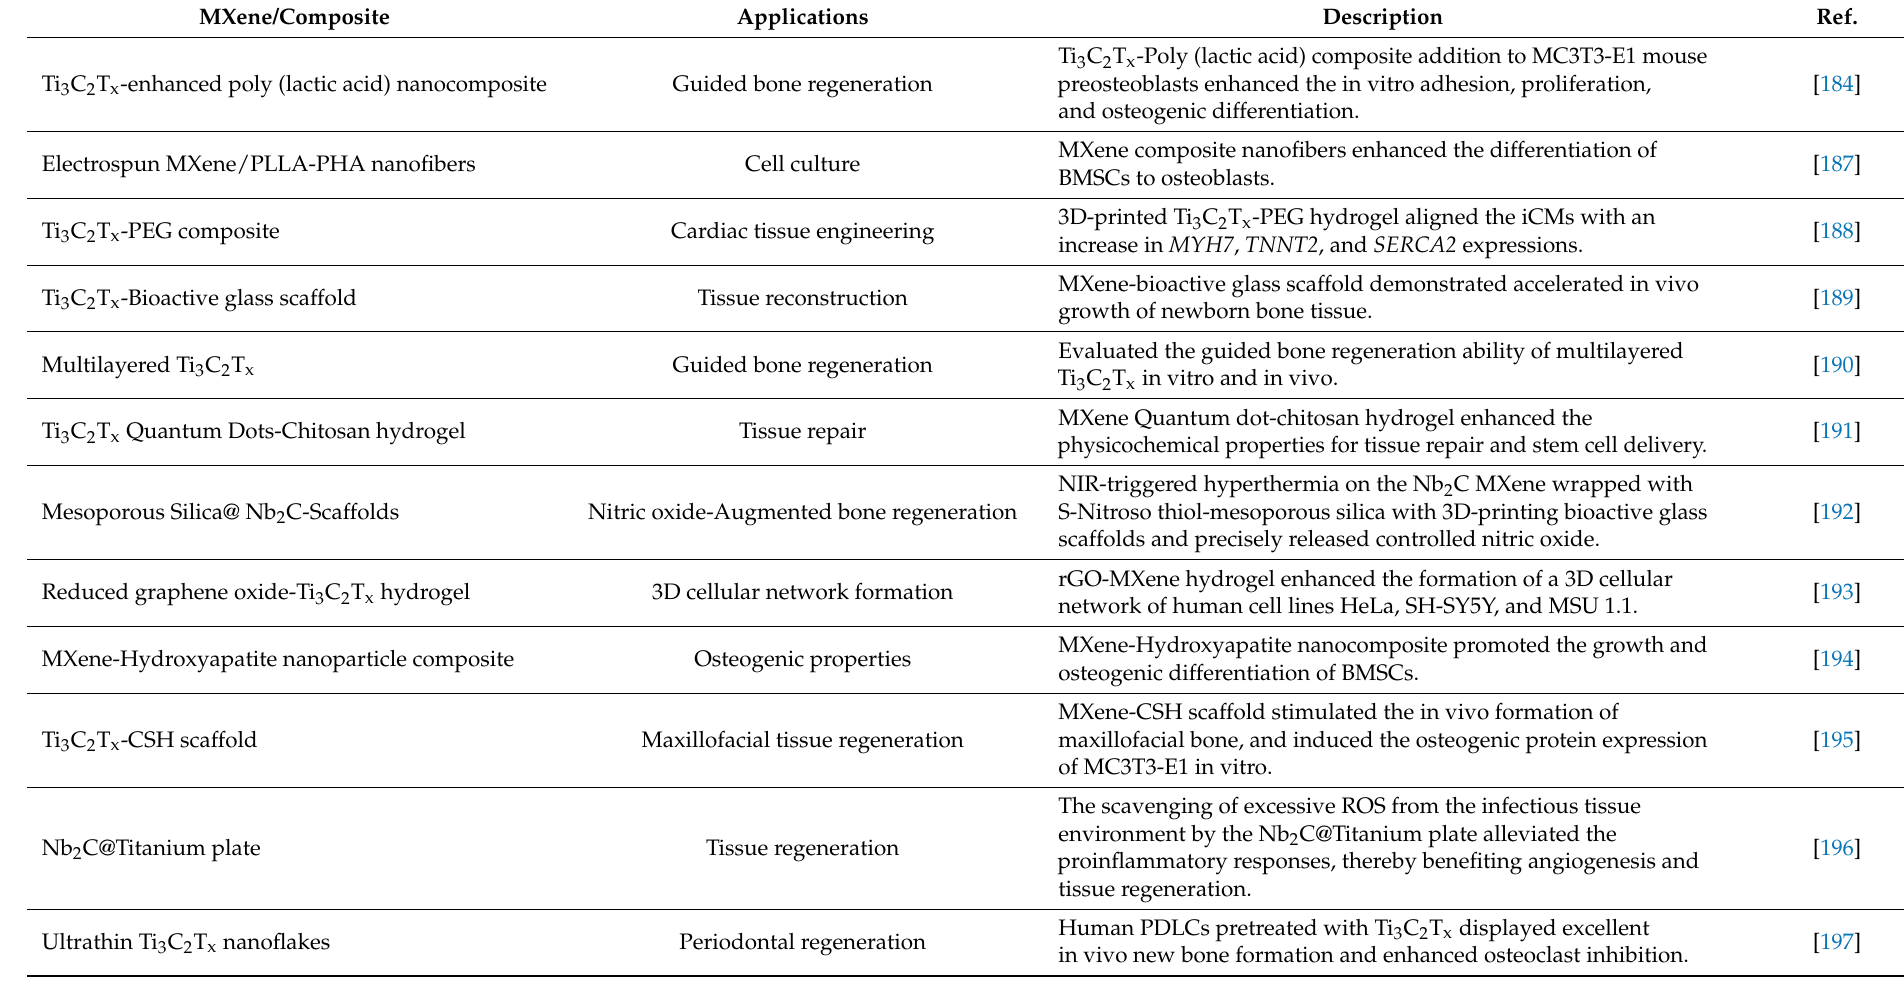
Table 6. Literature reports on the tissue engineering applications of